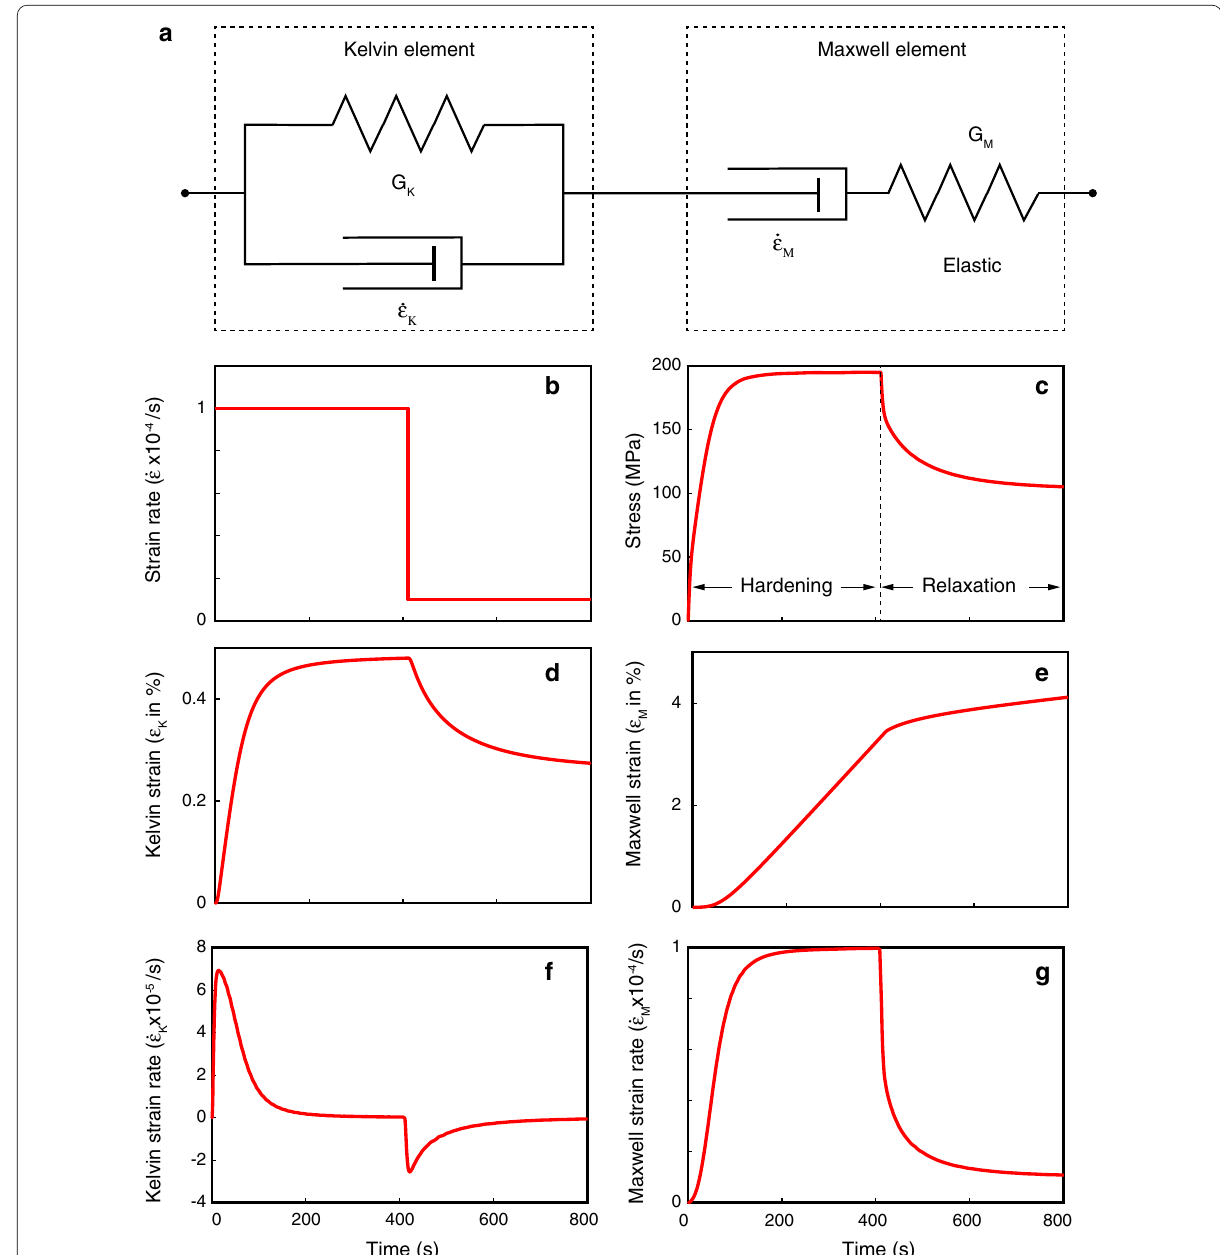
Fig. 1 Schematic of the nonlinear Burgers model and ideal stress-versus-strain curve for olivine aggregates. a The Maxwell element has a dashpot and the spring in series. The spring in the Maxwell element represents the elastic strain, where G M is the Young’s modulus, and the dashpot represents the long-term inelastic strain. The Kelvin element has the spring in parallel with the dashpot, and represents the transient inelastic strain, where G K is the hardening coefficient. b) Strain rate as an input to the nonlinear Burgers model. c – g Stress, Kelvin strain, Maxwell strain, Kelvin strain rate, and Maxwell strain rate response in the nonlinear Burgers model,